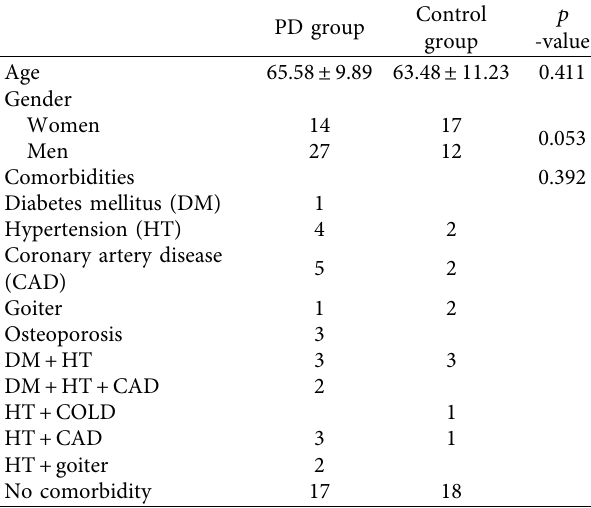
Table 1: Demographic and clinical characteristics of the PD and the control